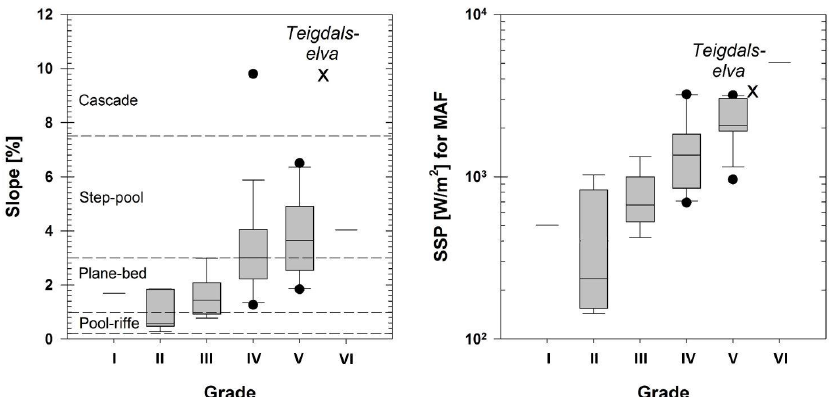
Figure 6. Box plot of the run-averaged values of slope ( left , with stream type thresholds according to Montgomery and Buffington [17]) and SSP of the kayak runs ( right ) as function of grade. Slopes were extracted based on water surface elevations of SK’s digital elevation model. Specific stream power (SSP) was calculated using mean annual floods (MAF) as reference discharge. The grade V reach of Teigdalselva River is highlighted with a cross. Water 2018 , 10 , x FOR PEER REVIEW